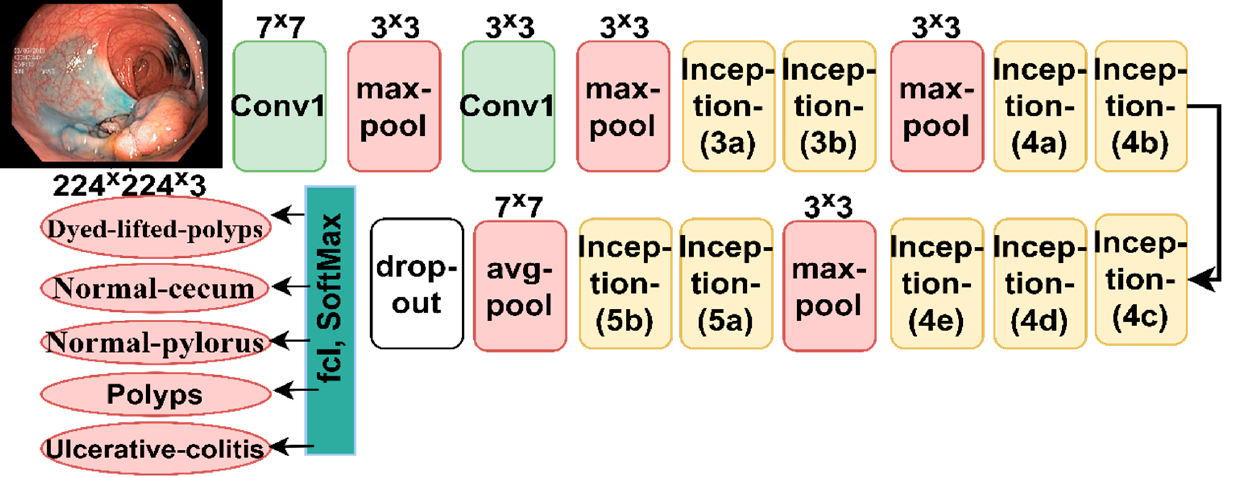
Figure 6. General structure of the GogLeNet model for classifying the lower GI endoscopy image dataset.